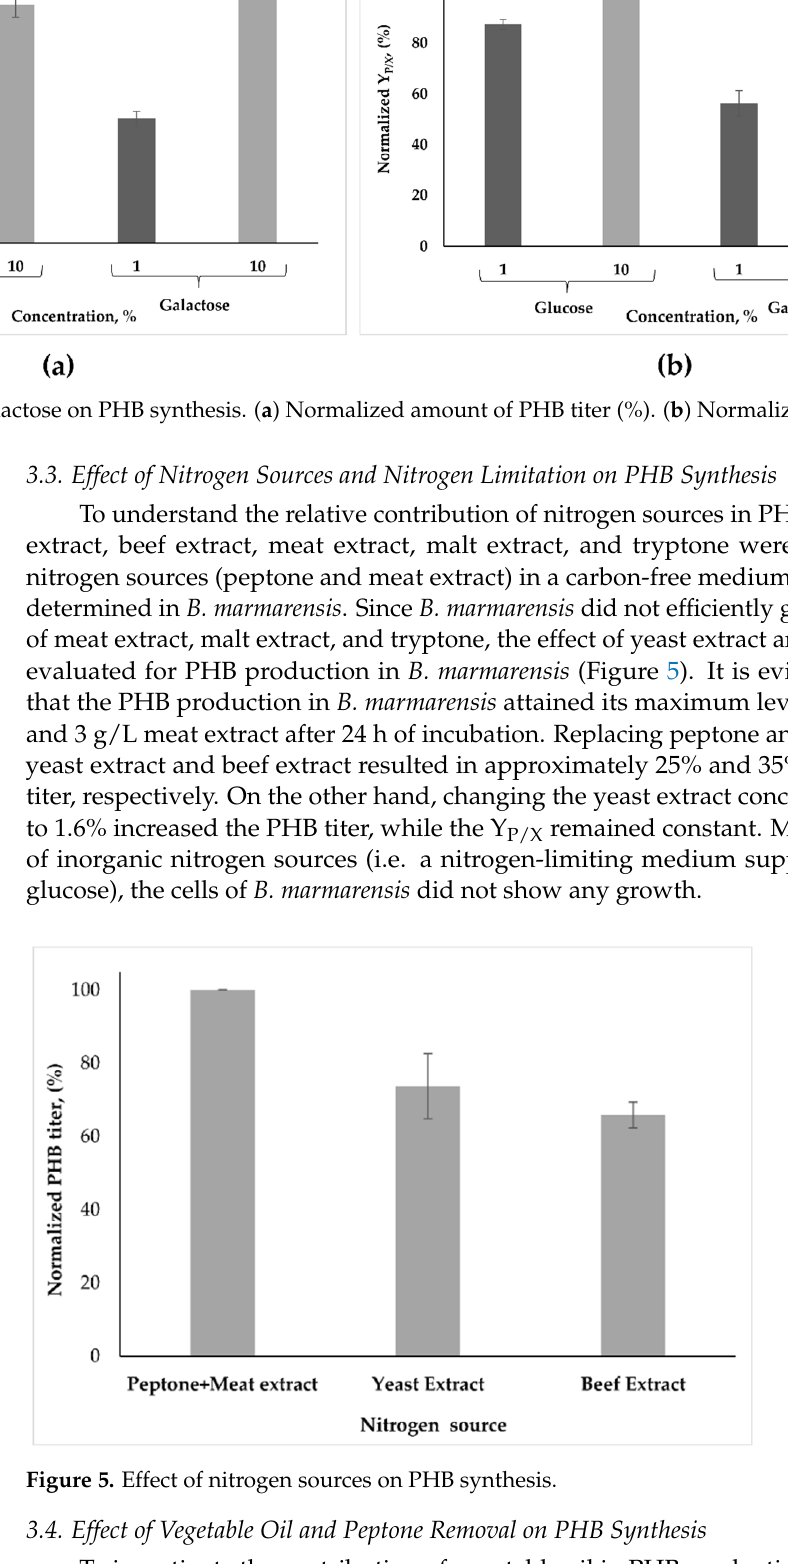
Figure 5. Effect of nitrogen sources on PHB synthesis.